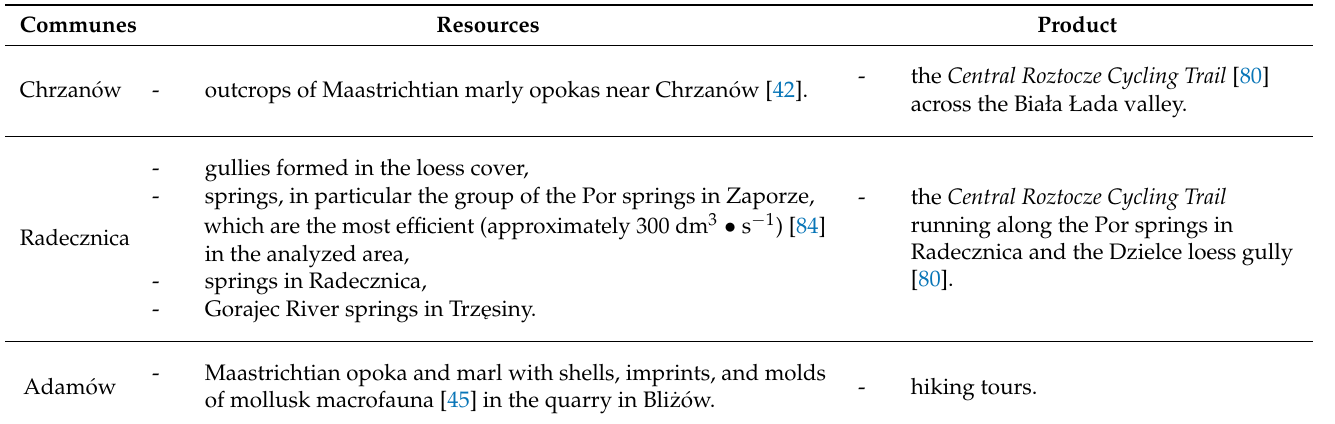
Table 9. Resources and products with moderate geotourism potential (TIGP = 0.061–0.122) in the communes. Communes Resources Product